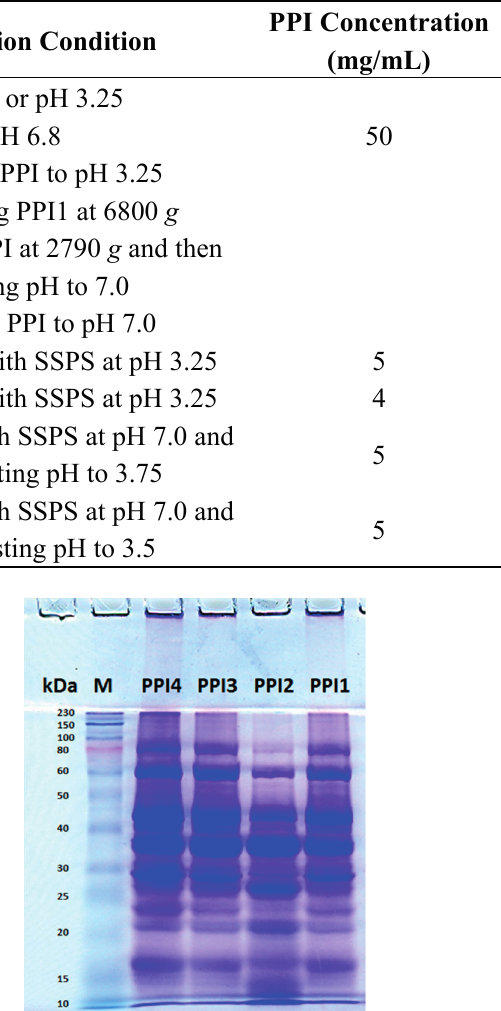
Table 1. Preparation conditions of various PPI and SSPS stock solutions and PPI/SSPS complex solutions.